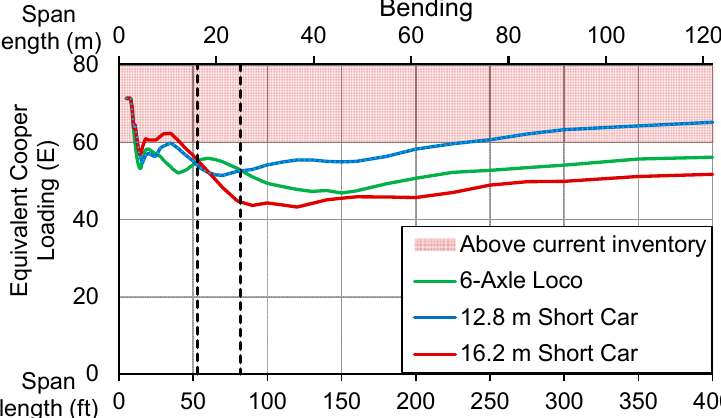
Figure 2. Cooper rating for bridge spans up to 122 m (400 ft) evaluated in flexural bending.